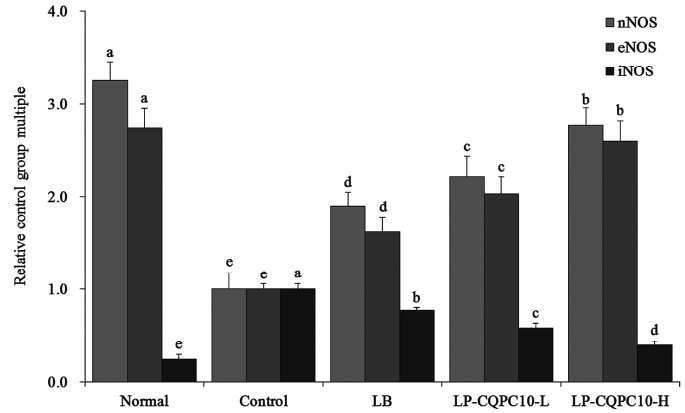
Figure 7. mRNA expression levels of nNOS, eNOS, and iNOS in the small-intestine tissue of mice. Values presented are the mean ± standard deviation. a–e Mean values with different letters in the same bars are significantly different ( p < 0.05) according to Duncan’s multiple-range test. LB: Lactobacillus bulgaricus (1.0 × 10 9 colony-forming unit (CFU)/kg body weight (bw)); LP-CQPC10-L: Lactobacillus plantarum CQPC10 (1.0 × 10 8 colony-forming unit (CFU)/kg body weight (bw)); LP-CQPC10-H: Lactobacillus plantarum CQPC10 (1.0 × 10 9 colony-forming unit (CFU)/kg body weight